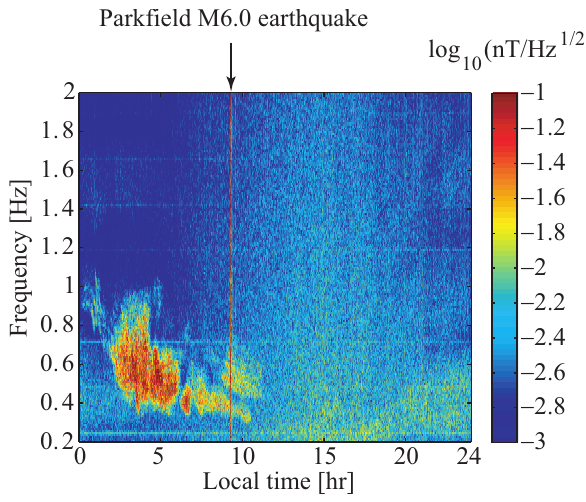
Fig. 1. Example of a Pc1 pulsation observed at the PKD search-coil magnetometer (see text) shortly before the M6.0 Parkfield earth- quake on 28 September 2004, 10:15:24 (PDT). The intense Pc1 pulsation is visible between 03:00–11:00LT, and f = 0 . 4 − 0 . 8Hz. We note that local time is taken to be Pacific Standard Time (PST, i.e. UT − 8) with no provision for daylight time